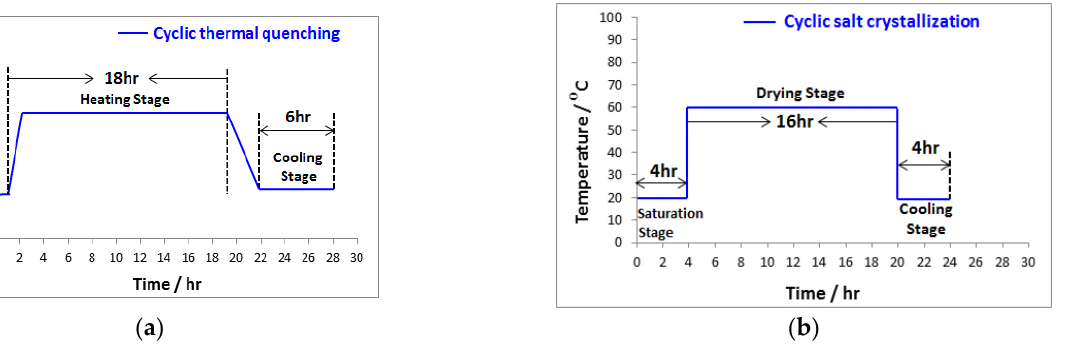
Figure 2. The temperature – time schematic diagram: ( a ) thermal quenching; ( b ) salt crystallization.